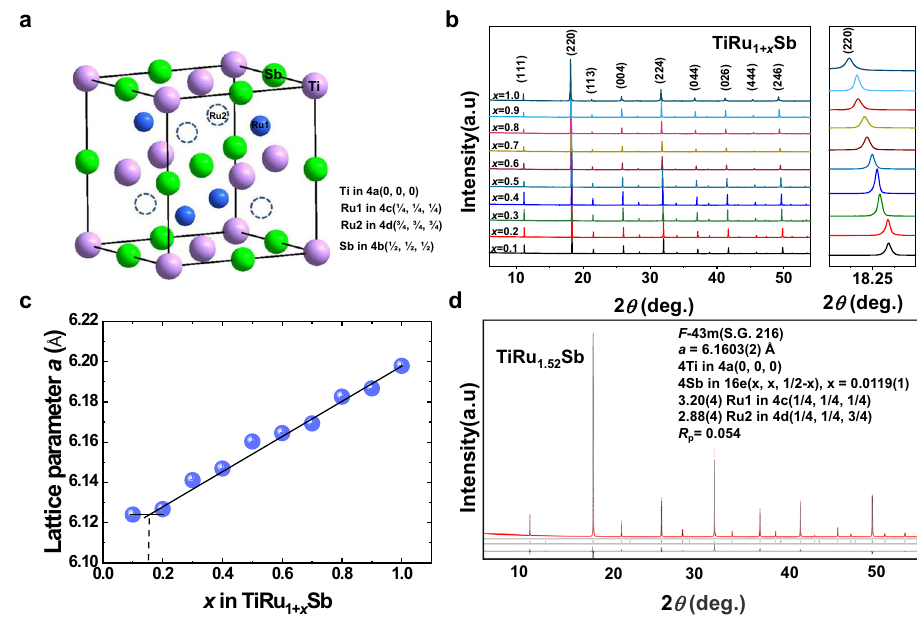
Fig. 1 Crystal structure of TiRu 1 + x Sb. a Schematic atomic arrangement in Heusler-type compounds. b SR-XRD patterns of TiRu 1 + x Sb samples. c Ru content-dependent lattice parameters of TiRu 1 + x Sb samples. d SR-XRD pattern of the TiRu 1.5 Sb sample together with the results of the crystal structure re fi nement.